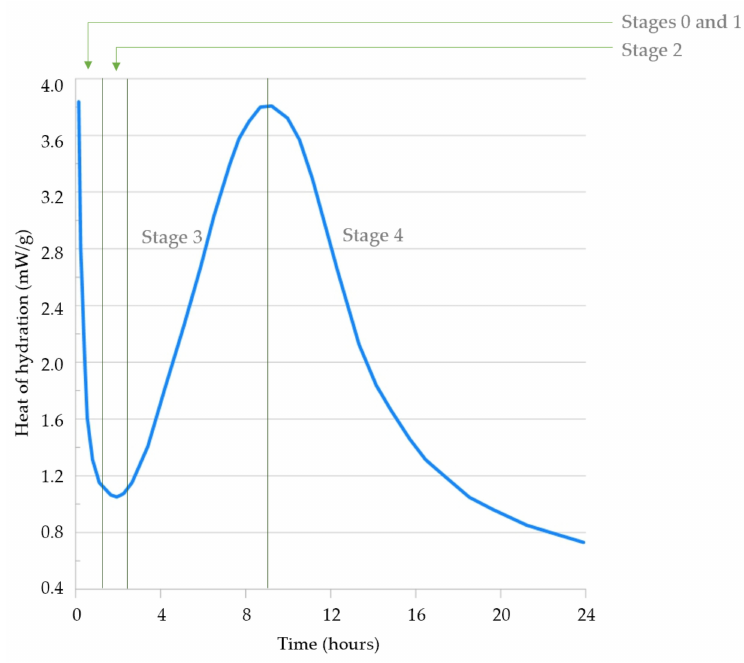
Figure 2. Experimental rate of hydration of alite(modified from